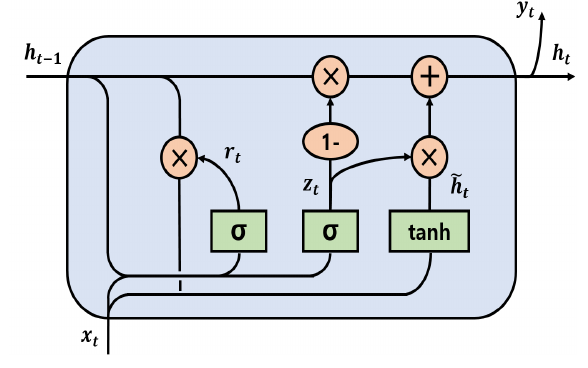
Figure 5. Internal structure of